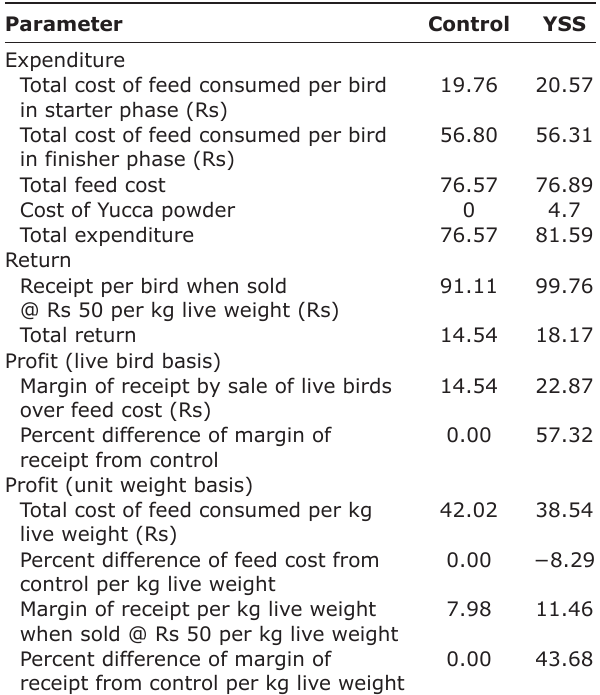
Table-5: Economic impact of treatment on broiler